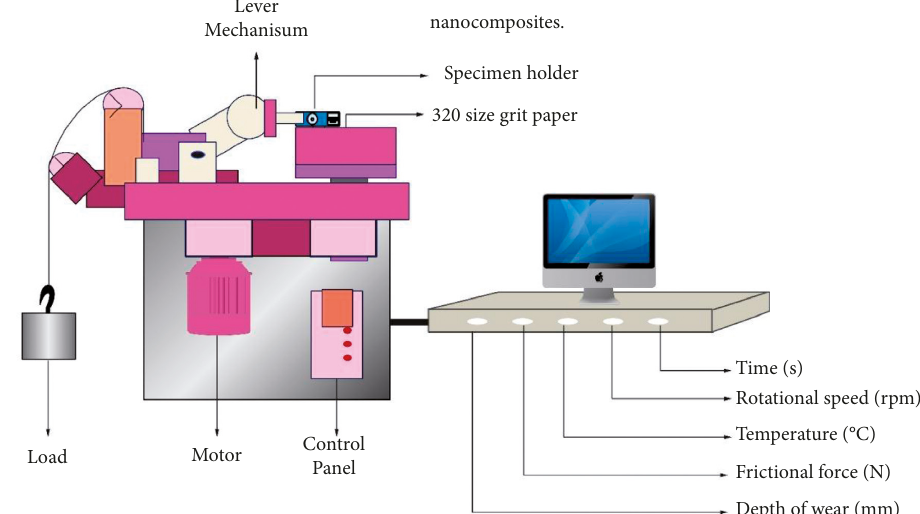
Figure 2: Schematic view of a pin on disc setup.